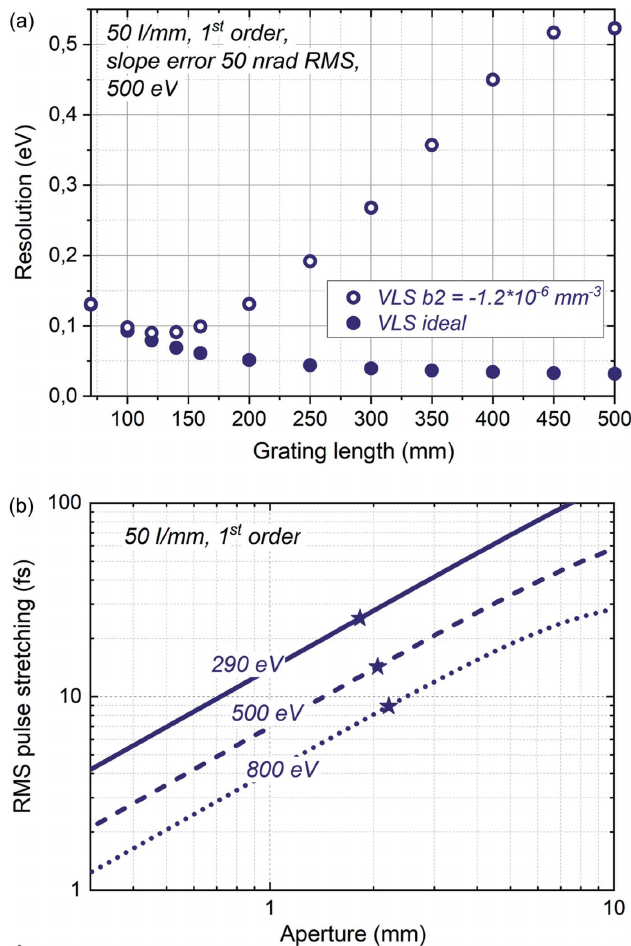
Figure 3 Influence of grating length on resolution and pulse stretching. ( a ) Dependence of analytically estimated resolution of the 50 l mm (cid:2) 1 grating with 50 nrad RMS slope error, operating in first diffraction order at 500 eVon the grating length. Solid circles – ideal VLS; open circles – VLS b 2 = (cid:2) 1.2 (cid:4) 10 (cid:2) 6 l mm (cid:2) 3 . ( b ) Pulse stretching versus open aperture upstream of the 50 l mm (cid:2) 1 grating operating in first diffraction order: solid line – 290 eV; dashed line – 500 eV; dotted line – 800 eV. The stars correspond to 120 mm length of grating